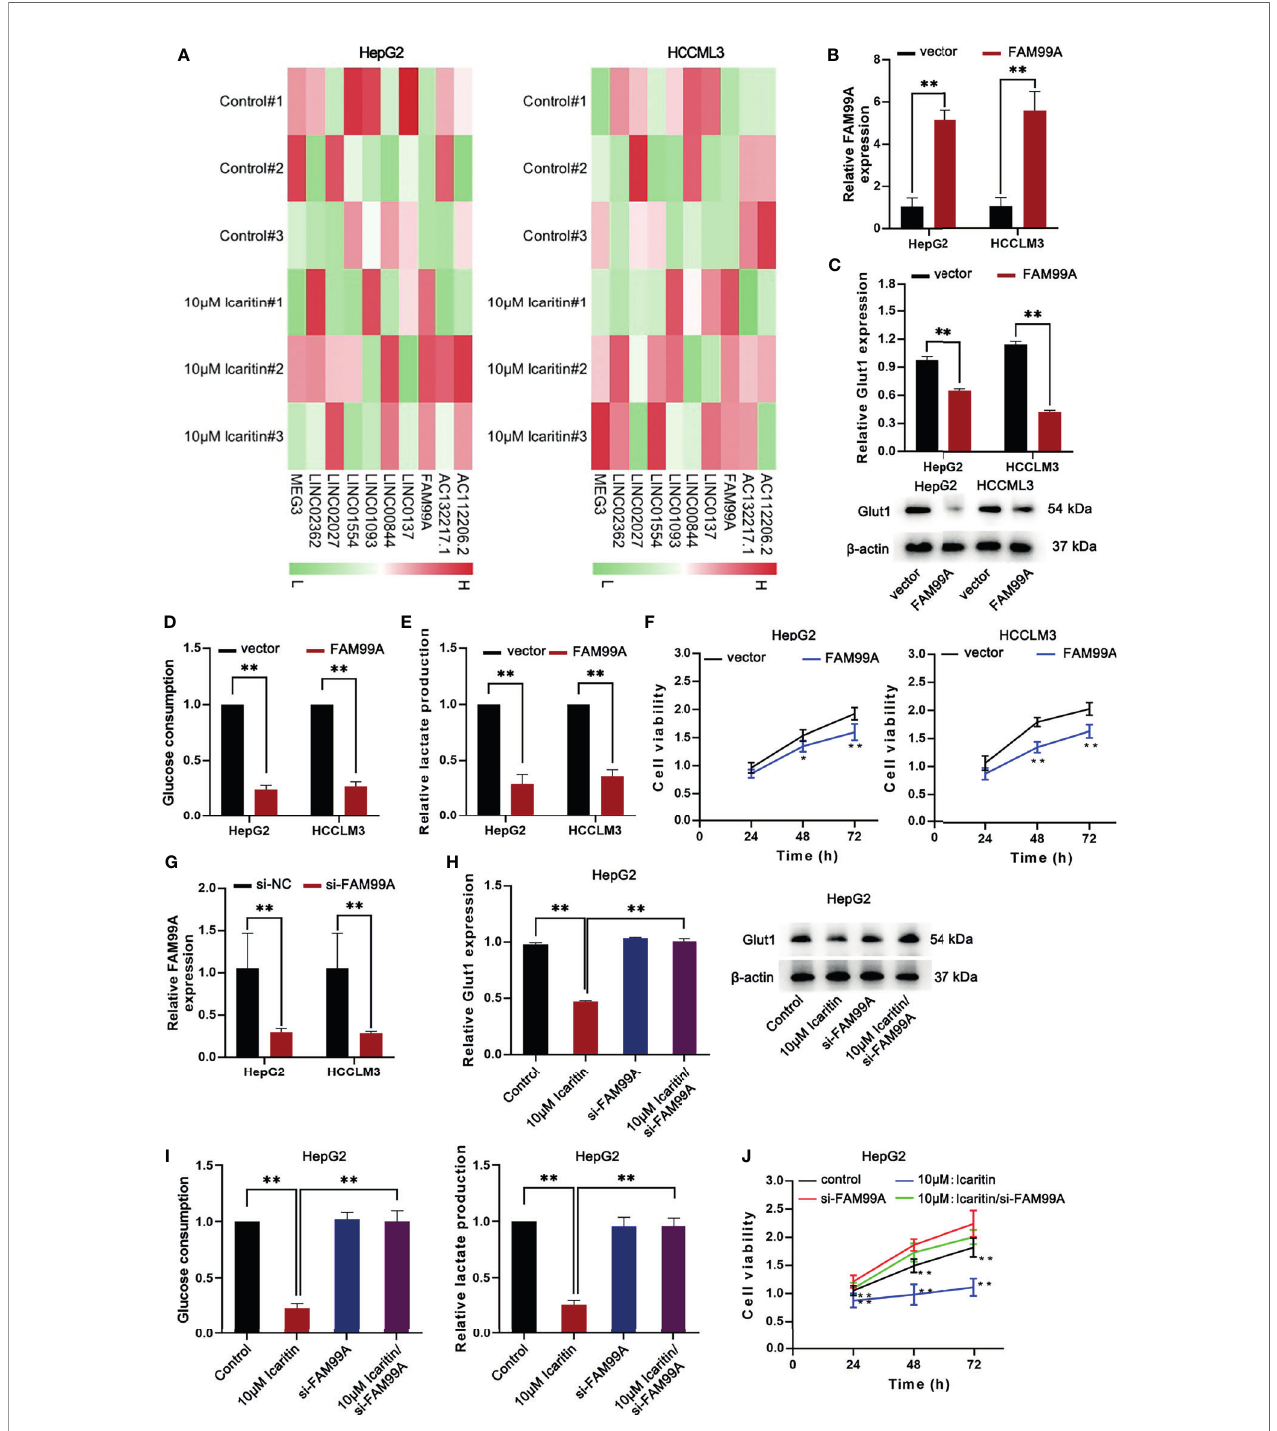
FIGURE 3 | Icaritin moderated the proliferation and Warburg effect of HCC cells via regulating the expression of FAM99A. (A) The heatmap shows the transcriptome sequencing of differentially expressed lncRNAs in HCC cells treated with icaritin (10 m m). (B) The expression of FAM99A was detected by qRT-PCR after HepG2 and HCCLM3 cells were transfected with pcDNA3.1/FAM99A. (C) The GLUT1 mRNA expression and protein levels in HCC cells were detected after the overexpression of FAM99A by qRT-PCR and Western blotting assays. (D, E) Glucose consumption and lactate production of HepG2 and HCCLM3 cells were detected. (F) MTT assay showed that the overexpression of FAM99A could lead to decreased cell viability of HCC cells. (G) The expression of FAM99A was detected. (H – J) Cell viability, GLUT1 expression, glucose consumption and lactate production of HCC cells transfected with si-FAM99A were detected. * P < 0.05, ** P <